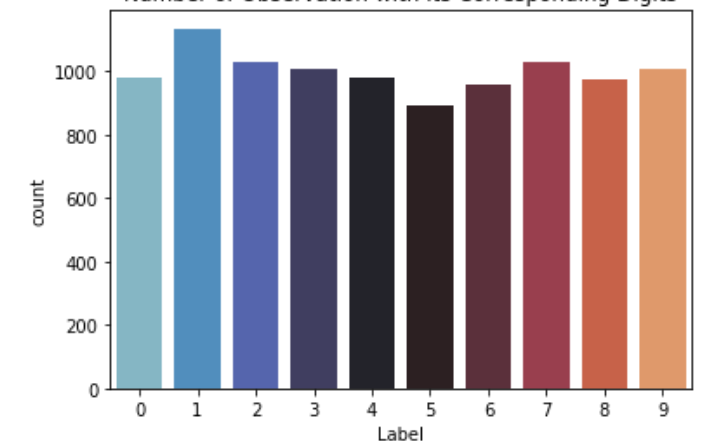
Figure 2 – Number of observations for each digit-testing set Рис. 2 – Количество распознаваний по каждой цифре в тестовом наборе Слика 2 – Број опсервација за сваку цифру у сету за тестирање Table 4 – Number of observations in the MNIST testing